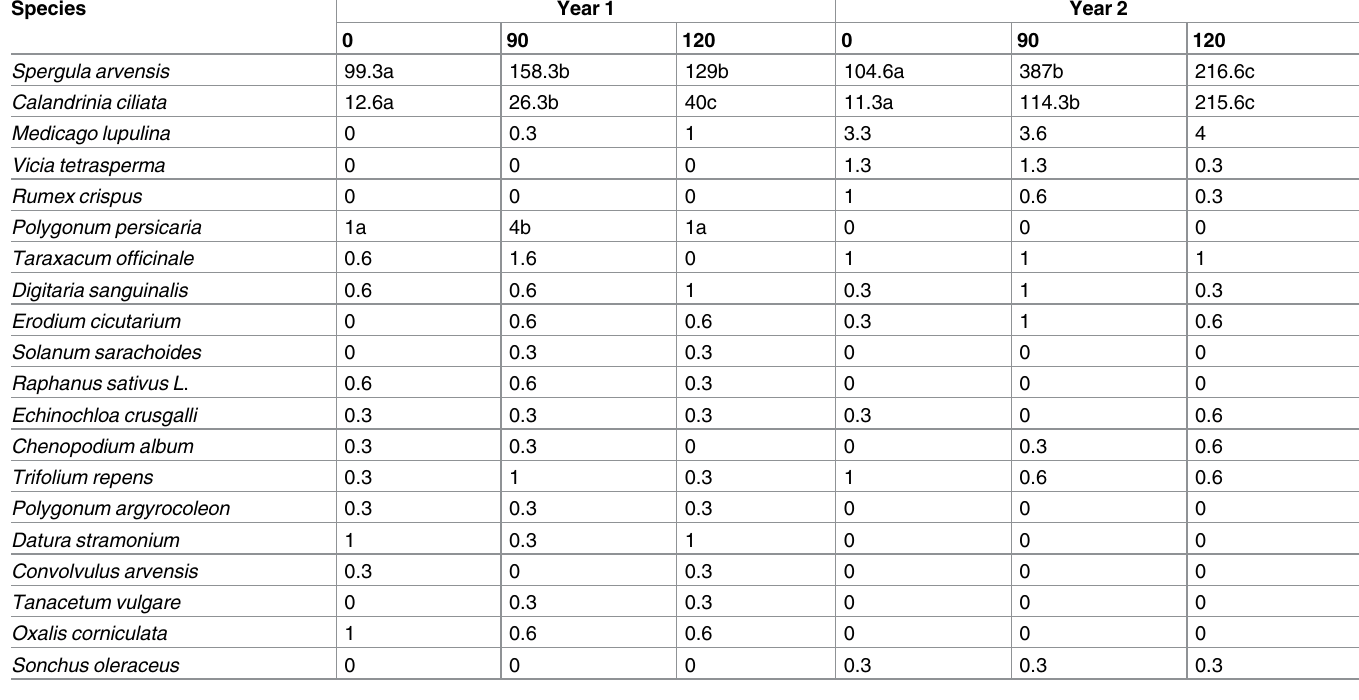
Table 3. Mean seedling density in 1 m 2 plots established from plant communities. selectedunder different episodic concentrations of tropo- spheric ozone (0, 90 and 120 ppb).